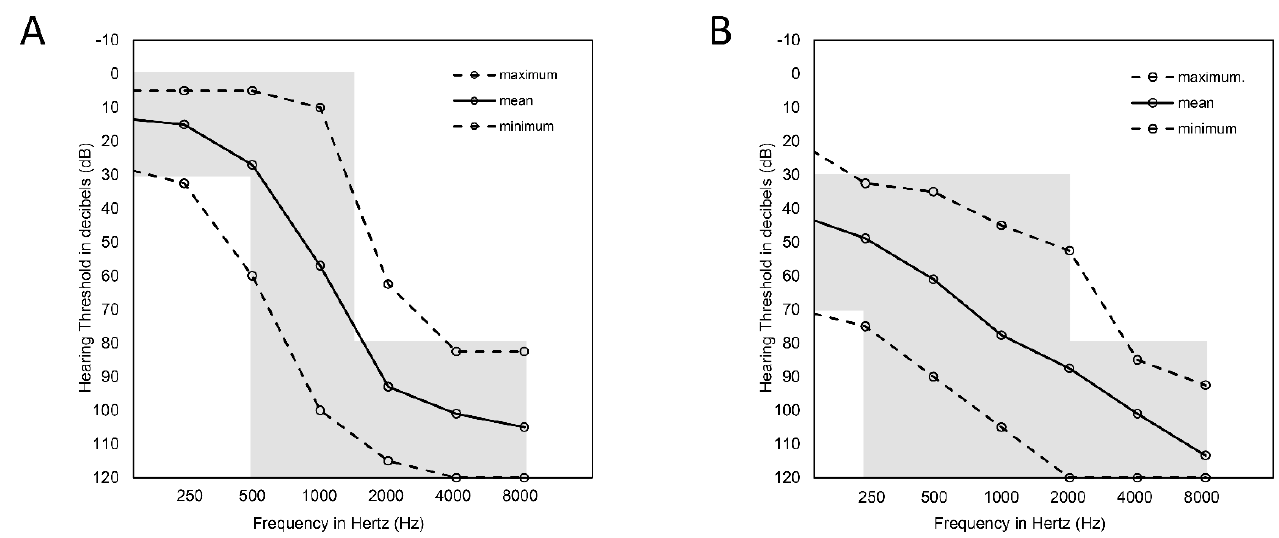
Figure 1. Mean pure-tone audiograms of the analyzed PDT patients. ( A ) Binaural hearing thresholds in the PDT-EC group; ( B ) Binaural hearing thresholds in the PDT-EAS group. Solid lines represent the average hearing level and dashed lines represent the maximum and minimum hearing thresholds.